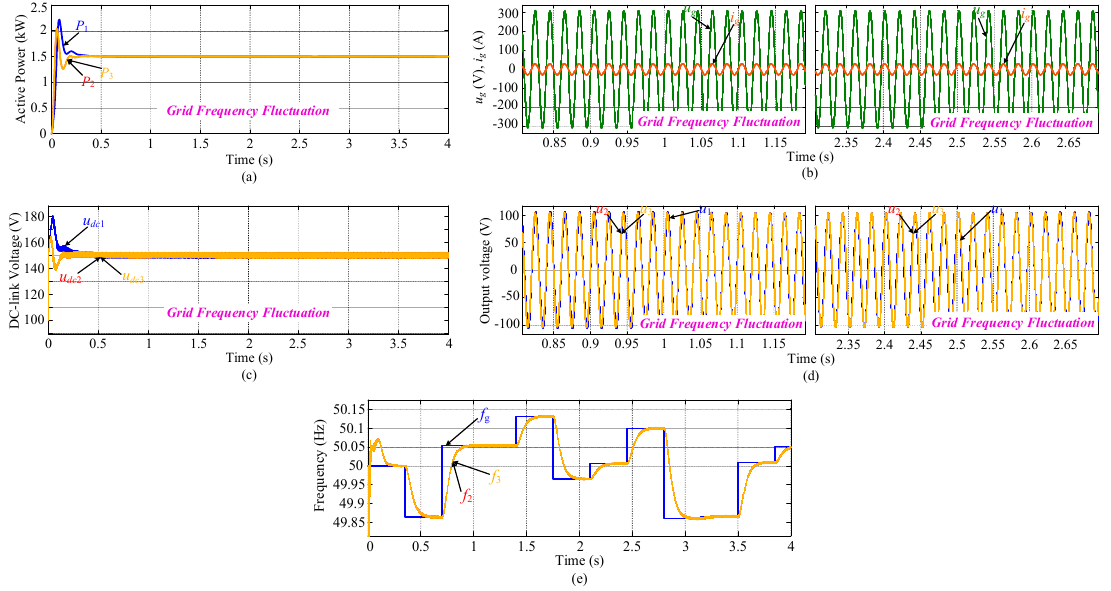
Figure 8. Simulation results under grid frequency fluctuation. ( a ) Active power; ( b ) Grid voltage and line current; ( c ) DC-link voltages; ( d ) Output voltages; ( e ) Frequencies. From Figure 8a,c P 1 ~ P 3 are identical and DC-link voltages u dc 1 ~ u dc 3 reach the same steady-state value, which indicates that the system operates under symmetrical condition and achieves